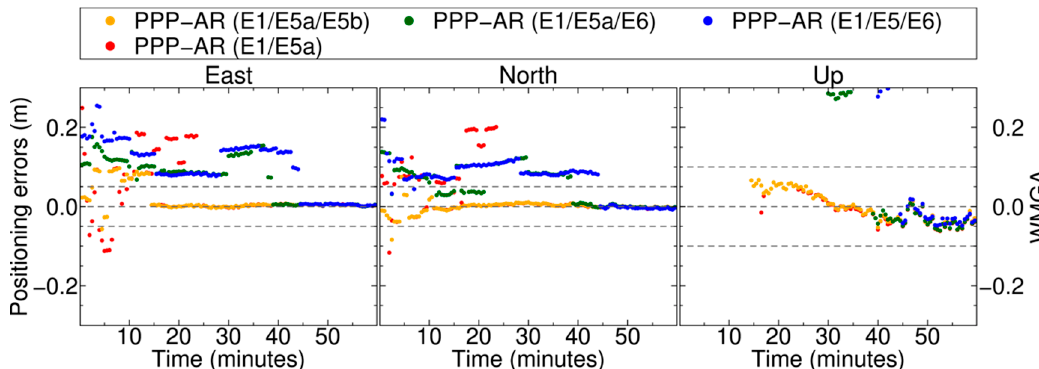
Figure 5. East, north, and up components of 1 h positioning errors (m) at Station WMGA on day 121, Figure5. East, north, andupcomponentsof1hpositioningerrors(m)atStationWMGAonday121, 2019. 2019. The solutions of dual-frequency (E1/E5a) and triple-frequency (E1/E5a/E5b, E1/E5a/E6, and The solutions of dual-frequency (E1 / E5a) and triple-frequency (E1 / E5a / E5b, E1 / E5a / E6, and E1 / E5 / E6) E1/E5/E6) PPP-AR with the official GPS receiver antenna corrections are shown in different colors. PPP-AR with the o ffi cial GPS receiver antenna corrections are shown in di ff erent colors. The horizontal The horizontal dashed lines represent the convergence regions. dashed lines represent the convergence regions. Remote Sens. 2020 , 11 , x FOR PEER REVIEW 12 of 17